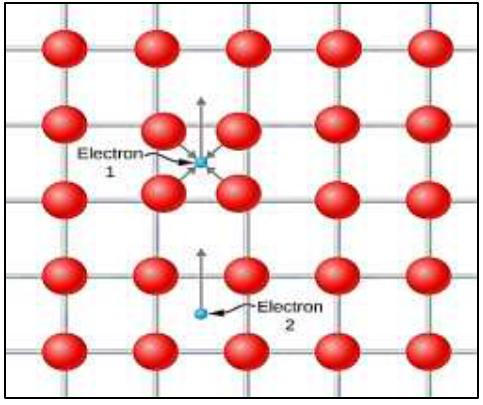
Figure 4: An illustration of the electron-phonon interaction. Electrons 1 and 2 form a Cooper